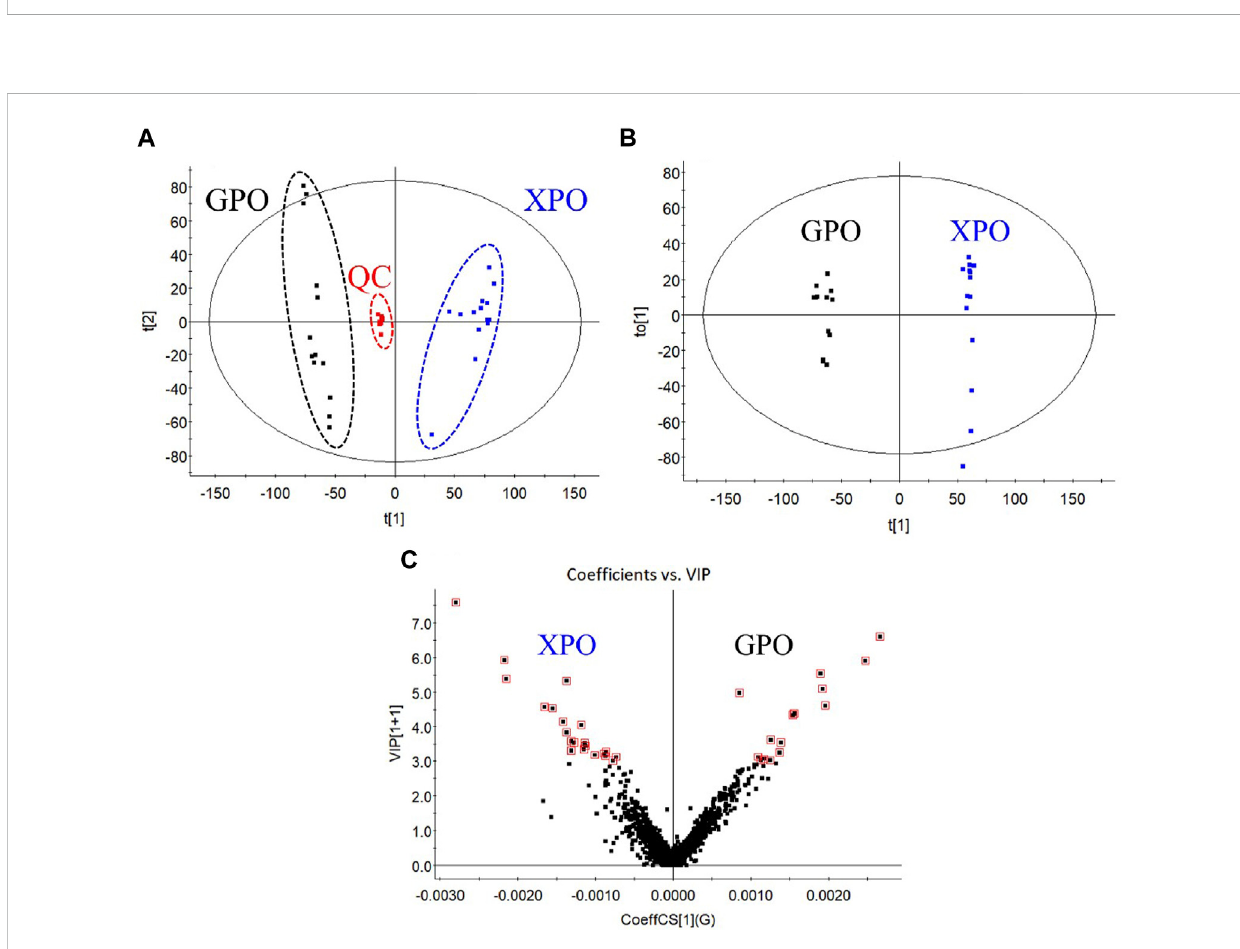
FIGURE 5 PCA score plot (A) , OPLS-DA score plot (B) , and VIP plot (C) of XPO and